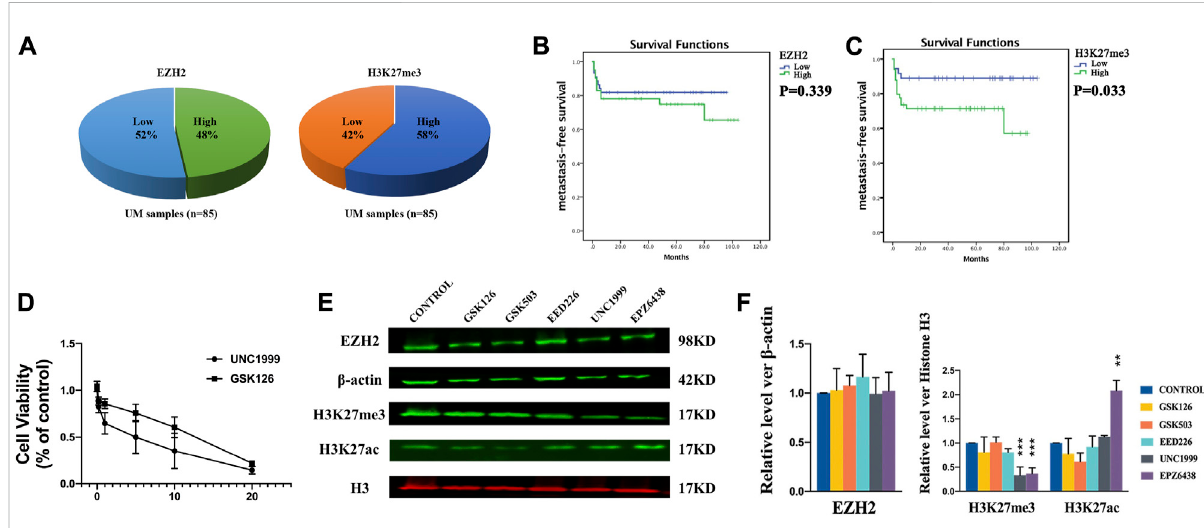
FIGURE 2 H3K27me3 was associated with prognosis. (A) The high expression of EZH2 accounted for 48%, and the high expression of H3K27me3 accounted for 57% in uveal melanoma samples. (B) Kaplan-Meier curves showed that expression of EZH2 was not statistically signi fi cant with metastasis. (C) Kaplan-Meier curves showed that the prognosis of patients with high H3K27me3 expression was worse than that of other patients. (D) The growth curves and IC50 values. (E – F) . EZH2, H3K27me3, and H3K27ac protein level after treatments of inhibitors of EZH2 by Western blotting. Among these inhibitors, UNC1999 and EPZ6438 reduce the expression level of H3K27me3. The expression level of H3K27ac was increased after treatment with EPZ6438. The position and background of Histone H3 (680 nm, red) and H3K27me3 (800 nm, green) are the same, and the fl uorescence intensity represents the expression of the protein. Data are expressed as mean ± SD from at least three independent experiments with triple replicates per experiment. (* p < 0.05, ** p <